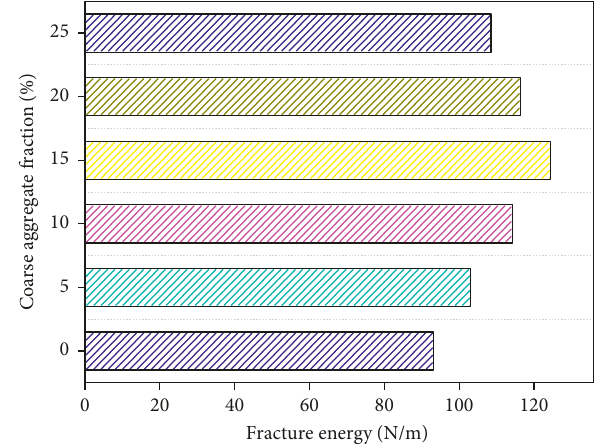
Figure 6: Ultimate load of the coarse aggregate interlocking concrete.